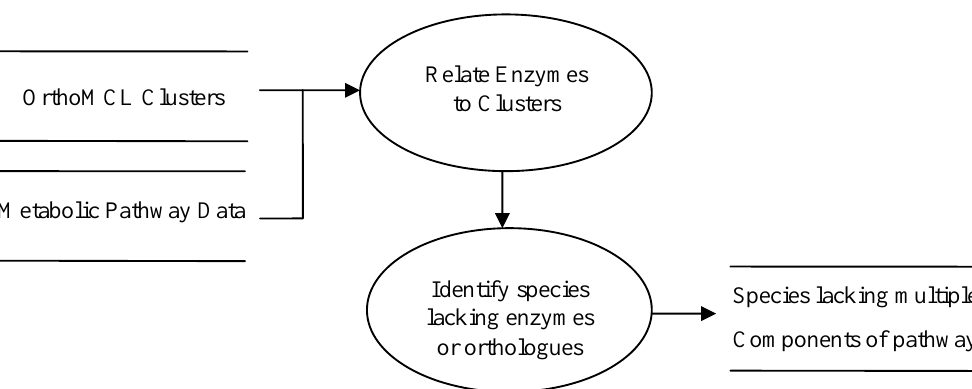
Figure 6: A data flow diagram for studying the conservation of